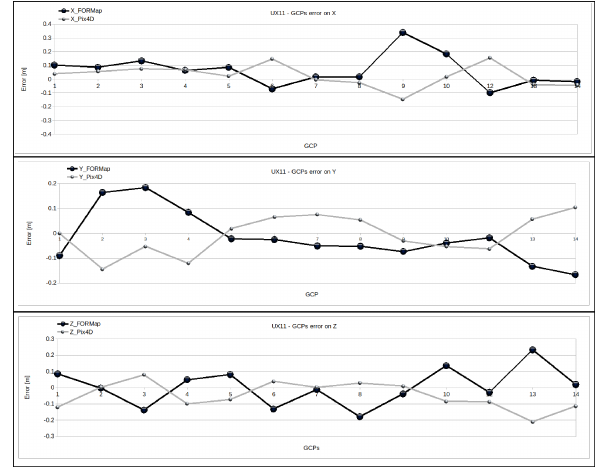
Figure 4. Accuracy assessment on GCPs of UX11 dataset. From the top : Euclidean distance, in X, in Y, in Z. Black line : FORMap, Grey line : Pix4D. The horizontal axis indexes the GCP number and the vertical axis is centered at 0 in all